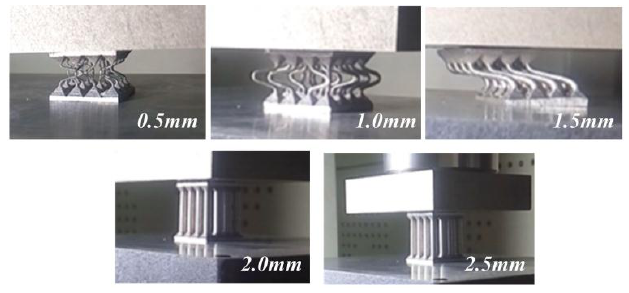
Figure 26. Results of compression tests.